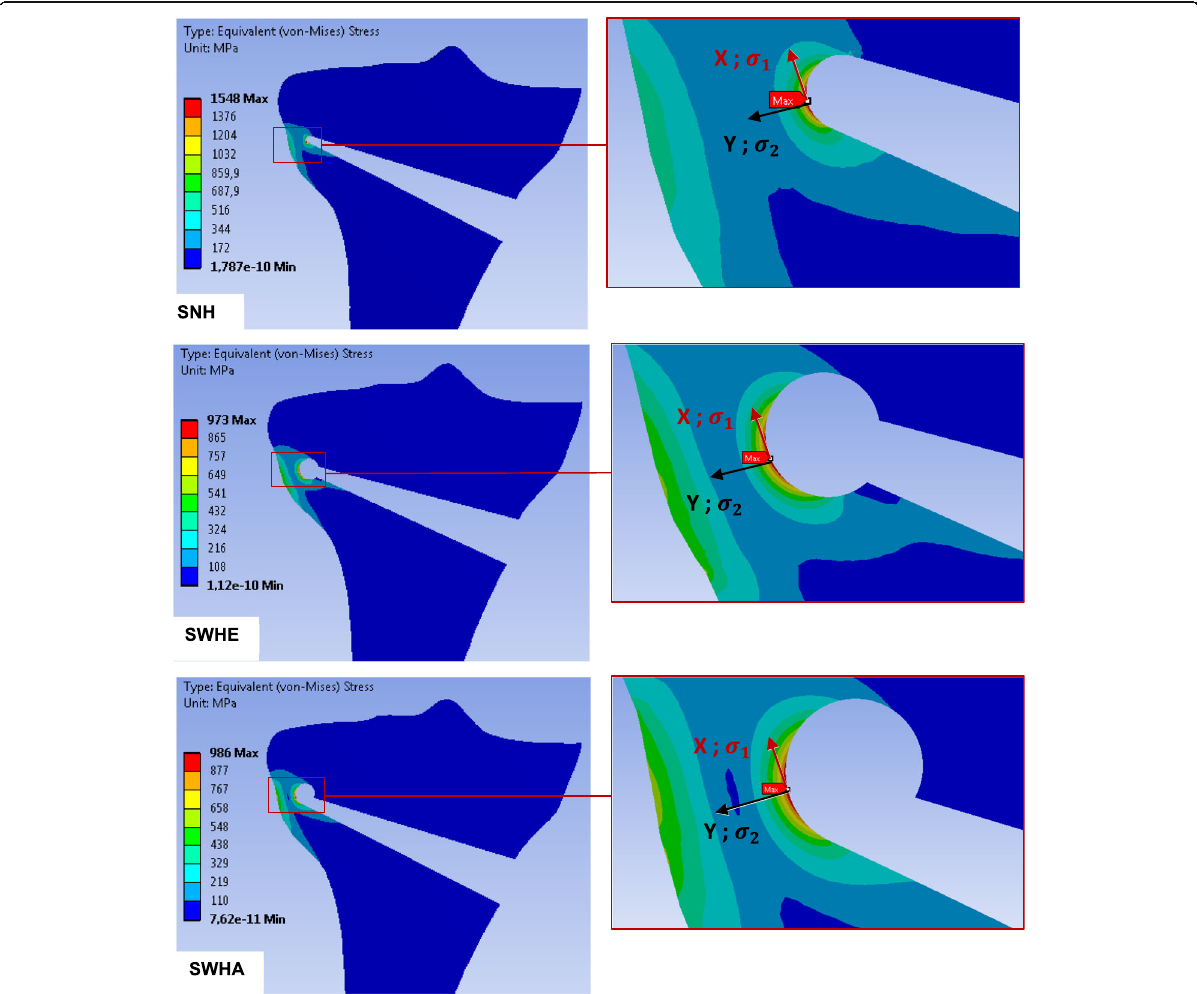
Fig. 9 Equivalent (von-Mises) stresses obtained with 2D linear FEA: The results represented here are for the case study H. The red hotspots with the maximum equivalent (von-Mises) stress indicate the locations of the reference points as illustrated on the zoom views. The stress values correspond to an opening angle of